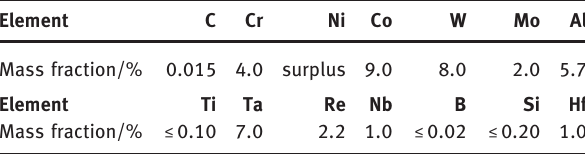
Table 1: The nominal chemical composition of the DD6 superalloy. Element C Cr Ni Co W Mo Al Mass fraction/%  .   .  surplus  . 